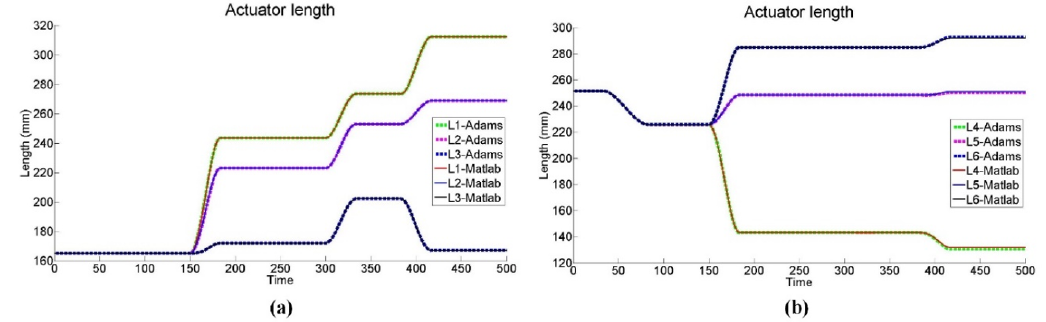
Figure 14. Evolution of the mechanism input variables during the simulated bone reduction trajectory.